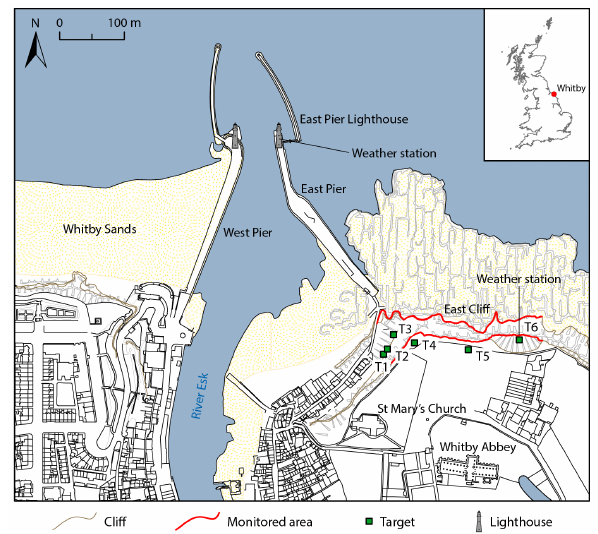
Figure 1. Map of Whitby with the area scanned delineated with red lines. A Riegl VZ-1000 scanner is installed within East Pier light- house. The targets installed for the SiteMonitor4D range correction factor estimation are illustrated (T1–T6) in addition to the weather stations. Whitby Abbey lies 180m from the cliff top. Map produced using shape files from Ordnance Survey© Crown Copyright and Database Right 2016. Ordnance Survey (Digimap